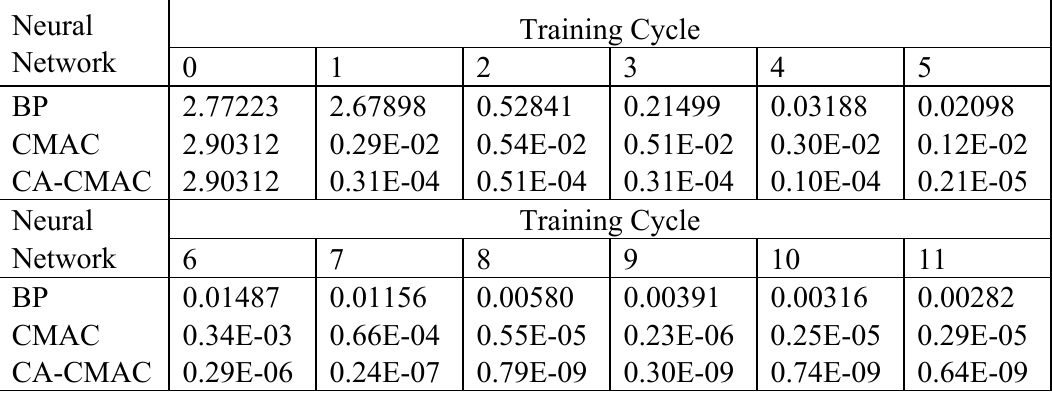
Table 1. MSE values by using different neural networks to train principal component